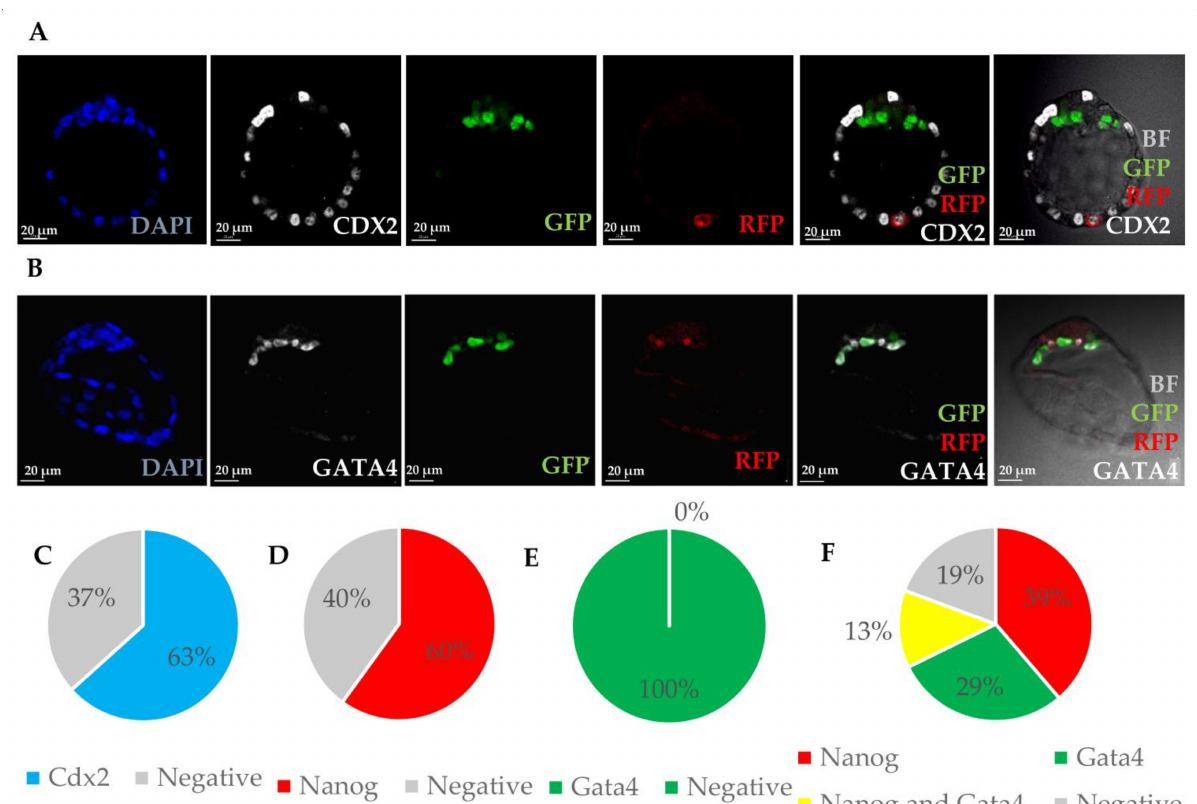
Figure 2. Expression of markers of blastocyst lineages in chimaeric blastocysts. ( A ) Immunofluorescence staining of chimaeric blastocyst. Chimaeric blastocyst with MEF cell expressing RFP (red) incorporated into trophectoderm and expressing CDX2 (white). Recipient embryo is expressing Pdgfra-GFP (green) in PrE cells. ( B ) Immunofluorescence staining of chimaeric blastocyst with MEF cells expressing RFP incorporated into primitive endoderm, 2 cells express Pdgfra-GFP and GATA 4, 1 cell expresses only GATA 4. ( C ) Chart showing percentage of cells stained for CDX2, positive and negative within cells located in TE stained for CDX2. ( D ) Chart showing percentage of cells stained for NANOG, positive and negative within cells located in ICM stained for NANOG (but not GATA4). ( E ) Chart showing percentage of cells stained for GATA4, positive and negative within cells located in ICM stained for GATA4 (but not NANOG). ( F ) Chart showing percentage of cells stained for NANOG and GATA4, expressing each marker within cells located in ICM, stained for NANOG and